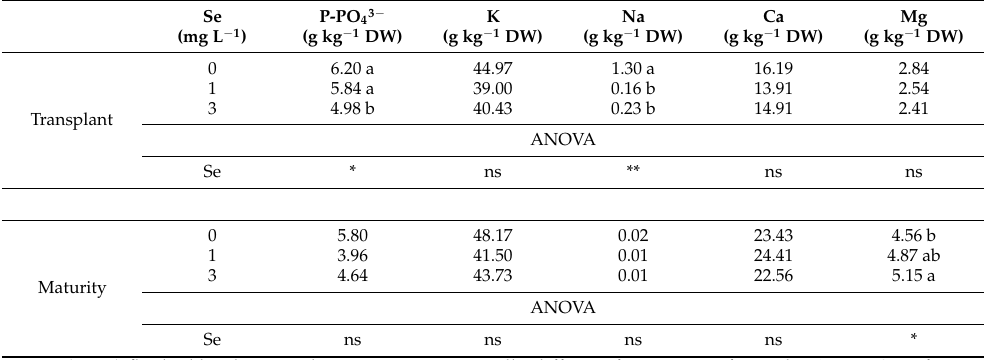
Figure 6. Fresh (FW) and dry (DW) weight, and dry matter percentage (DW/FW) of basil plants, measured at transplant ( A – C ) and maturity ( D – F ), treated with different concentrations of Se at pre- transplanting. In subfigure ( A , C ), means ( n = 3) flanked by different letter are statistically different for p = 0.05 after Tukey’s test. Table 4. Phosphate (P-PO 43 − ), potassium (K), sodium (Na), calcium (Ca) and magnesium (Mg) content, measured at transplant and maturity, in basils plants treated with different concentrations of Se at